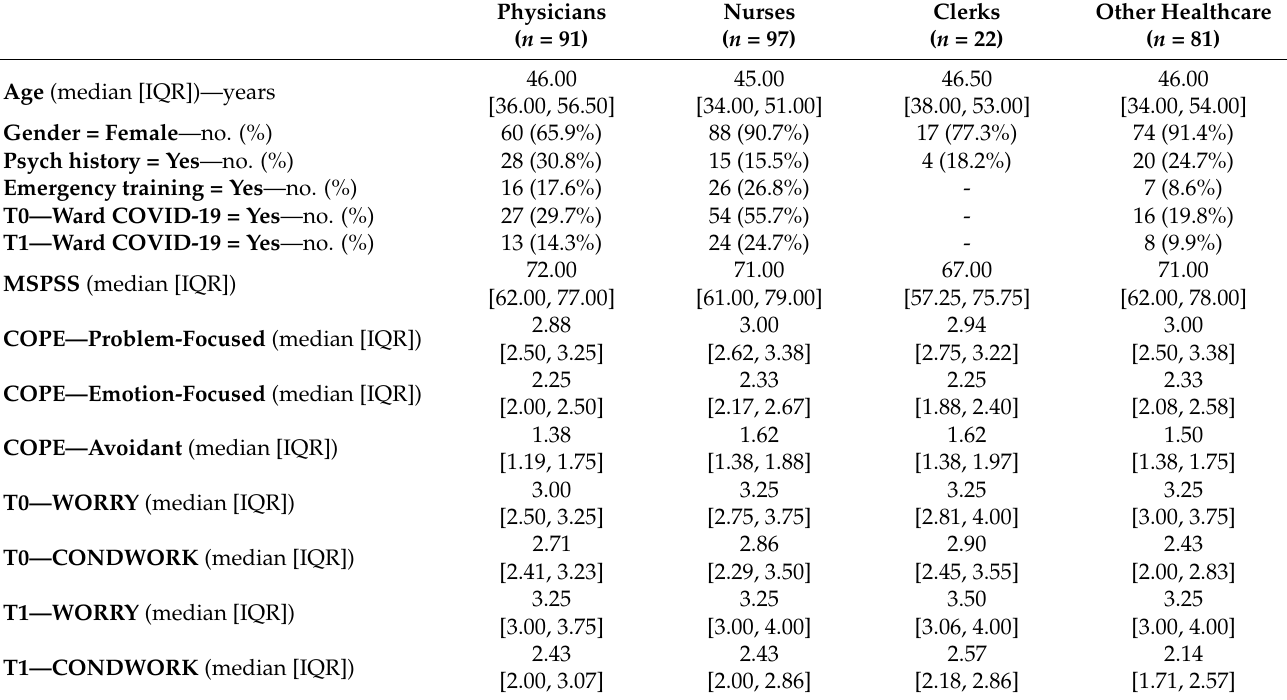
Table 2. Demographic, clinical, and occupational characteristics stratified by occupation ( n =